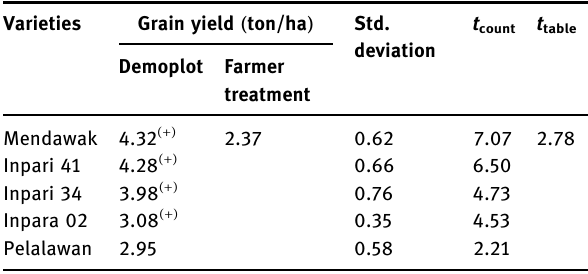
Table 6: Average of each observation characters Varieties